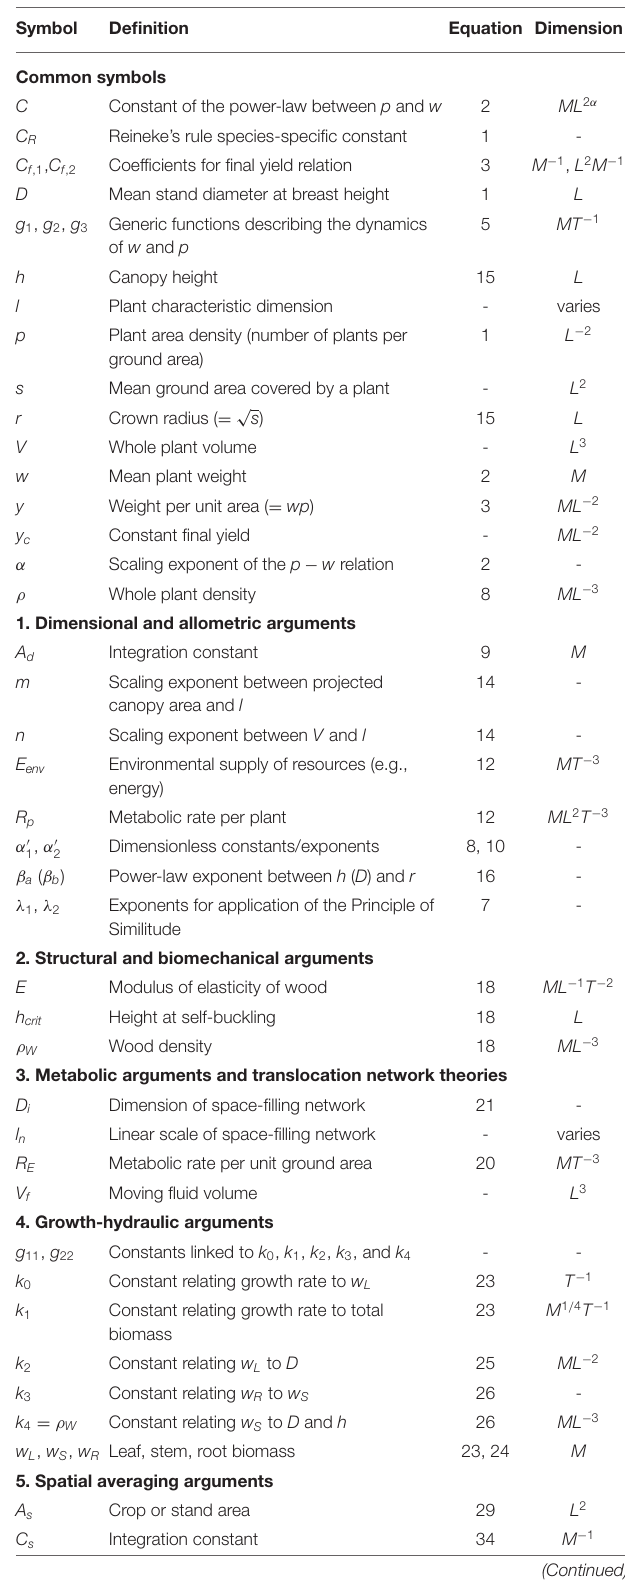
TABLE 2 | List of symbols with definitions, equation where they are first used, and